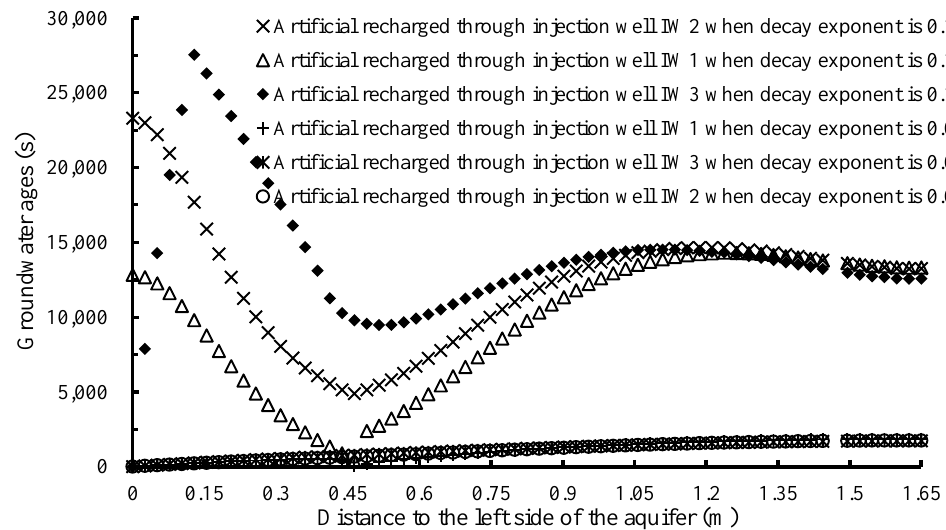
Figure 11. Groundwater age at the bottom of the aquifer driven by artificial recharge through injection wells at different locations and different decay exponents.